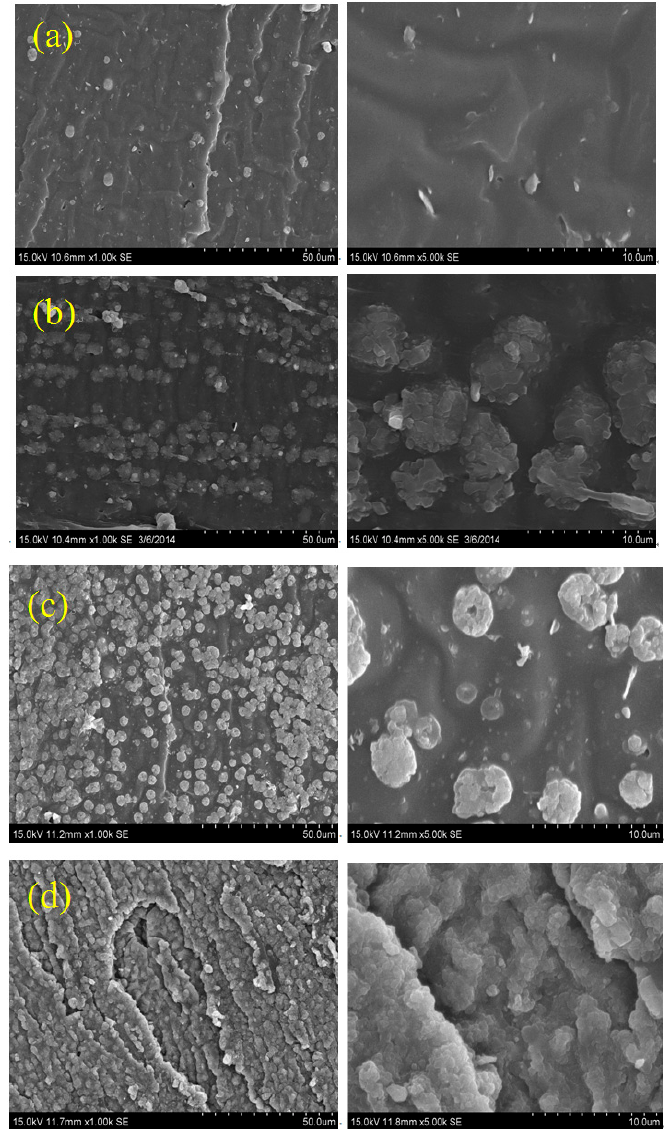
Figure 3. SEM of ( a ) NR/FR-DOMt-5, ( b ) NR/FR-DOMt-10, ( c ) NR/FR-DOMt-15, ( d ) NR/FR-DOMt-20.